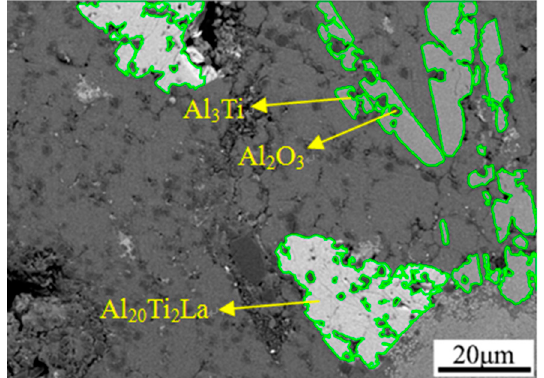
Figure 1. Area measurement schematic.